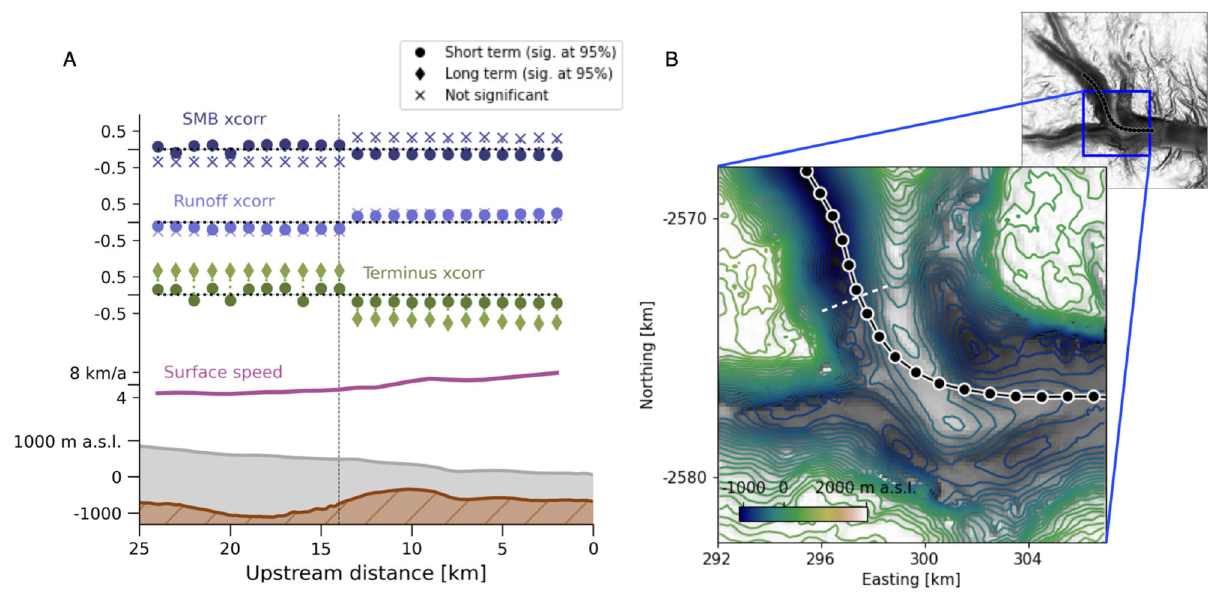
Fig.4|In fl uenceofasubglacialridgeonHelheimGlacierdynamics.A Icespeed cross-correlation with each variable tested, for each point along the fl owline, ver- tically offset for legibility. Variable labels coincide with zero cross-correlation and minor ticks indicate XCorr( f , v )=±0.5. Darker circles are cross-correlations of the full signals (as reported in Fig. 2 and the fi rst Results section). Lighter diamonds show results fi ltered to isolate long-term variability (as in Results section header “ Multi-annual... ” andFig.S6).Resultsnotsigni fi cantlydifferentfrom0areassigned a cross marker, as in Fig. S6. Lower portion shows bed topography (brown), ice